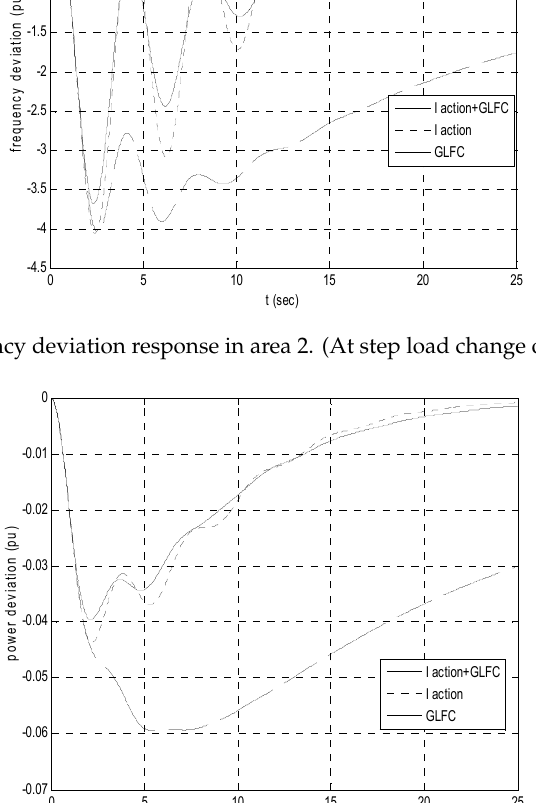
Figure 10. The tie line power deviation response. (At step load change of 250 MW in area